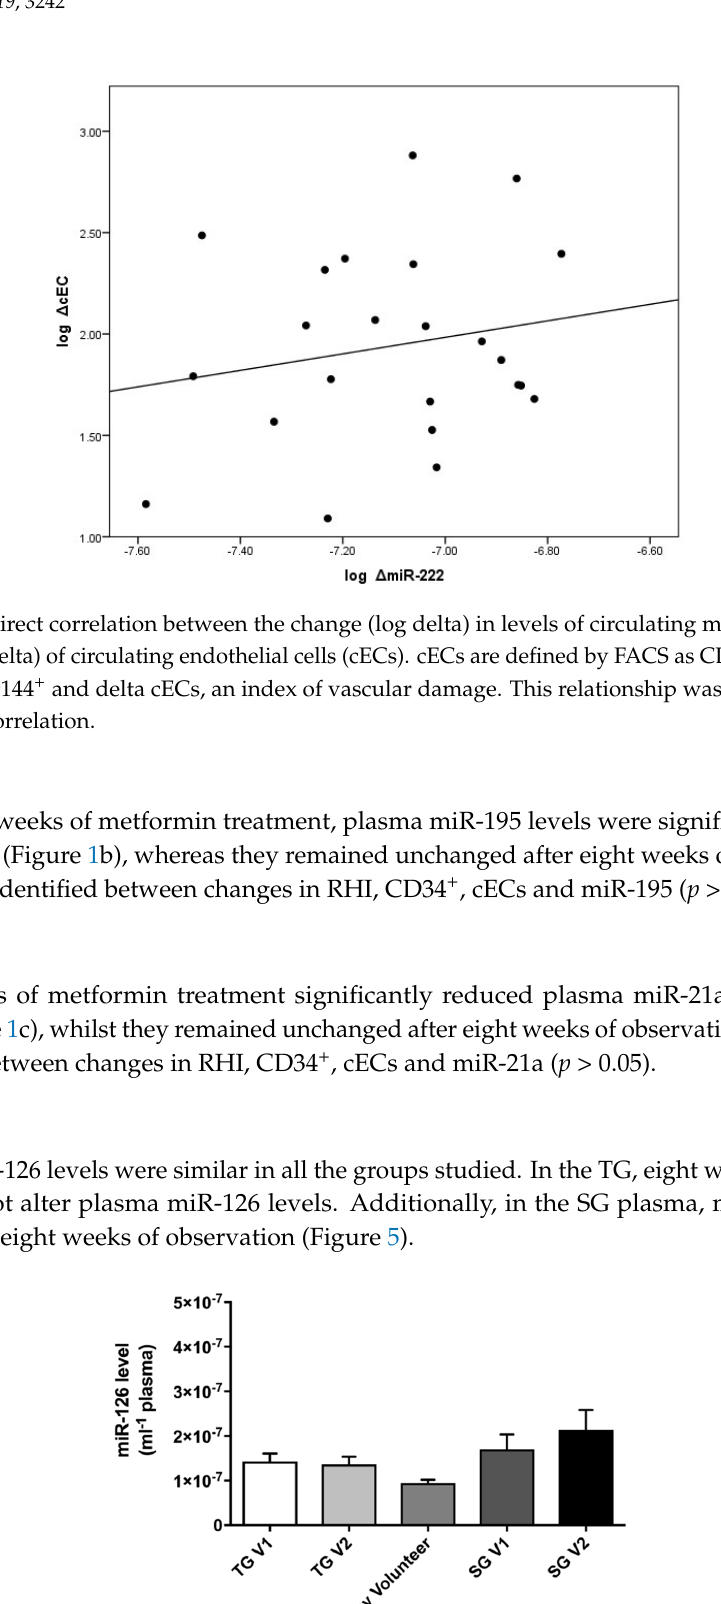
Figure 5. A comparison of the plasma levels of miR‐126 (per mL) in all groups. The results are presented as the mean ± SEM. Treatment group pre‐metformin (TG V1), treatment group post‐ metformin (TG V2), standard group pre‐observation (SG V1) and standard group post‐observation (SG V2).